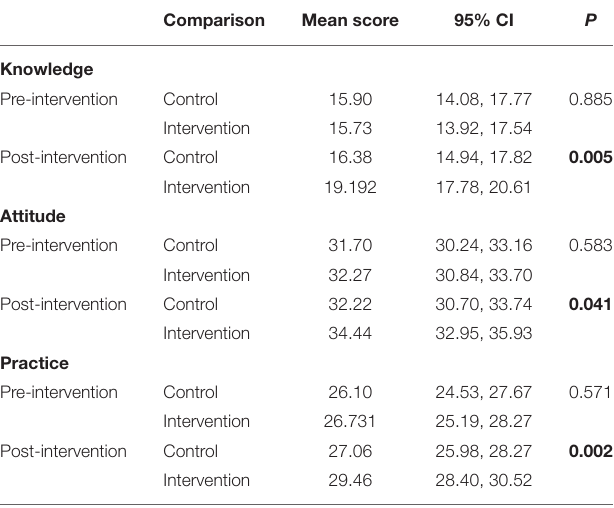
TABLE 4 | Comparison of KAP score for RTI prevention among the intervention and control group based on time (Time-treatment interaction).